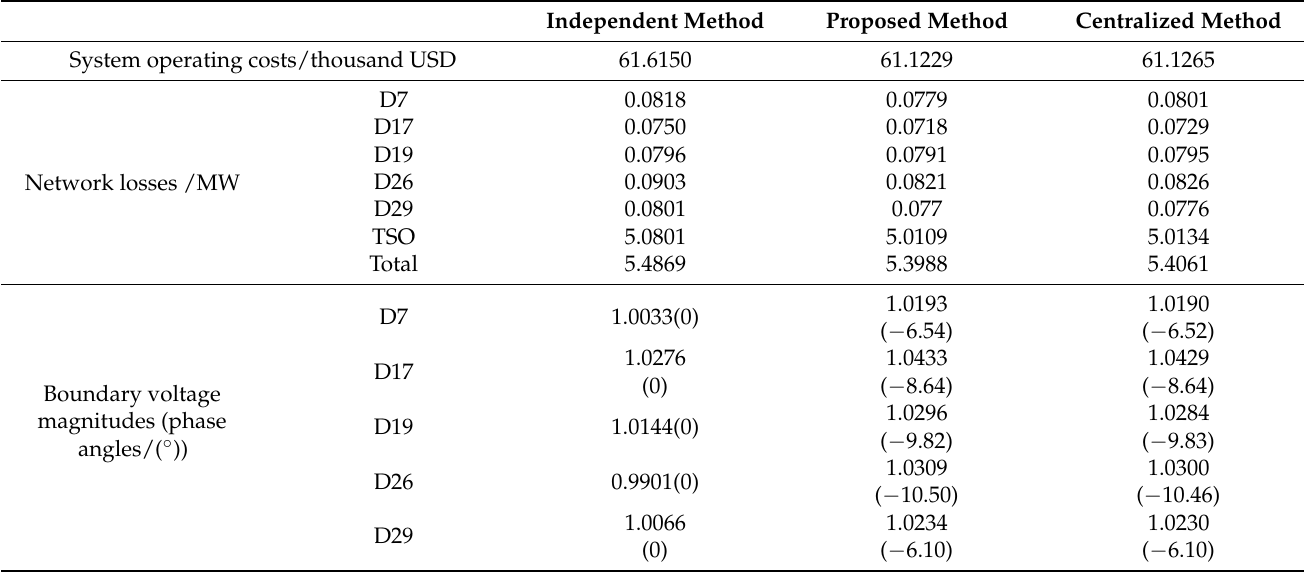
Table 4. Comparison of the results of solving test case 3 by different